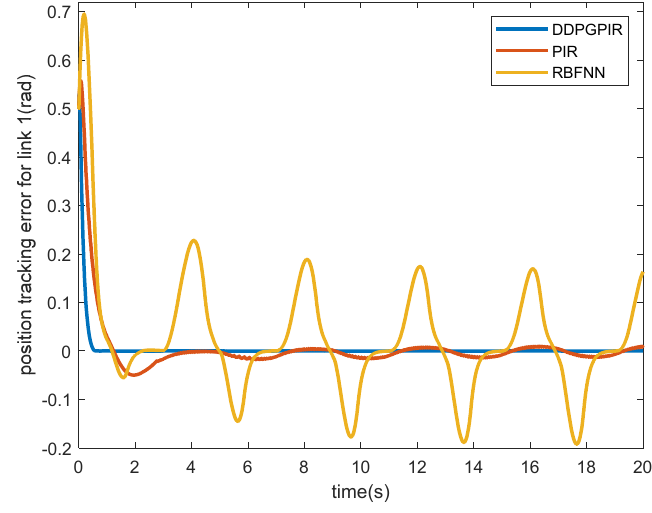
Figure 10. Tracking error of joint 1.